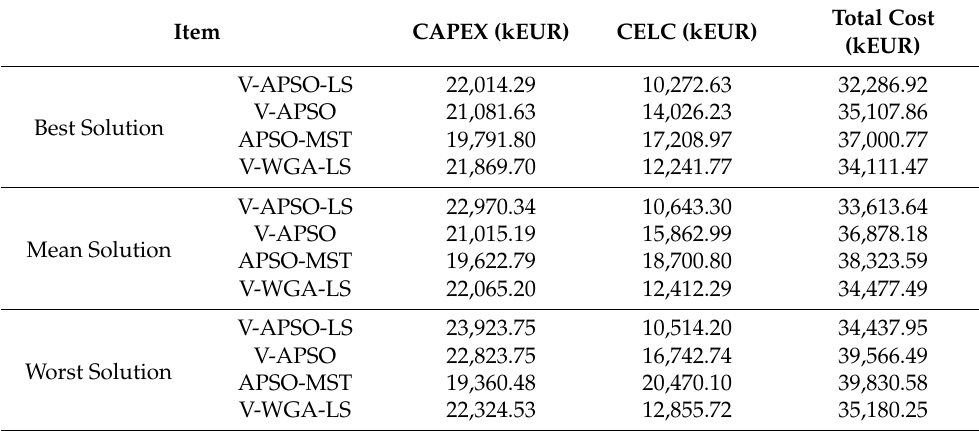
Table 2. The best, mean and worst solutions obtained by different algorithms in 10